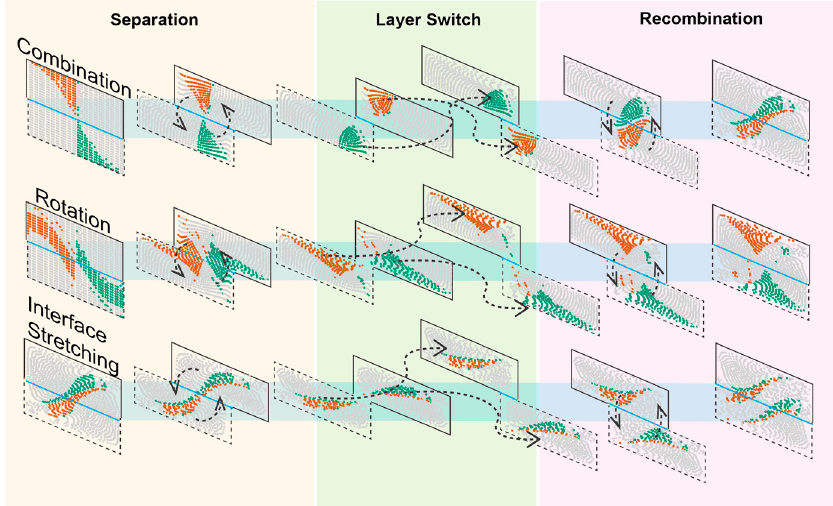
Figure 6. Three mixing effects in the mixing unit. Specific sections or zones from Fluid 1 and Fluid 2 inputs are colored brown and green, respectively. These zones are transformed in separation, layer switch, and recombination stages in the mixing unit/cycle.